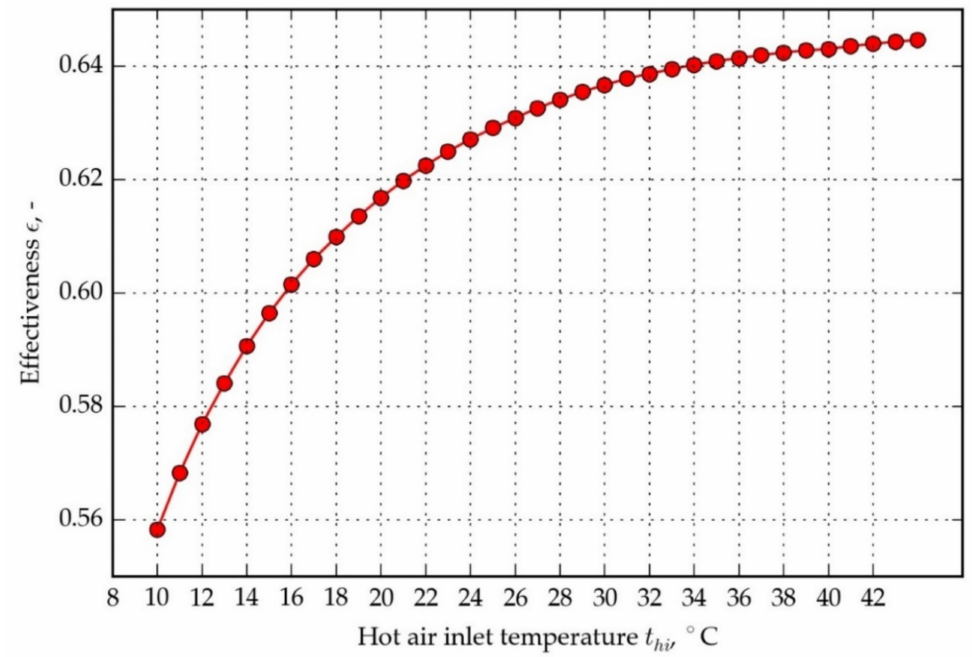
Figure 13. Effectiveness vs. hot air inlet temperature, for cold stream inlet temperature 0 ◦ C and 20 HPs